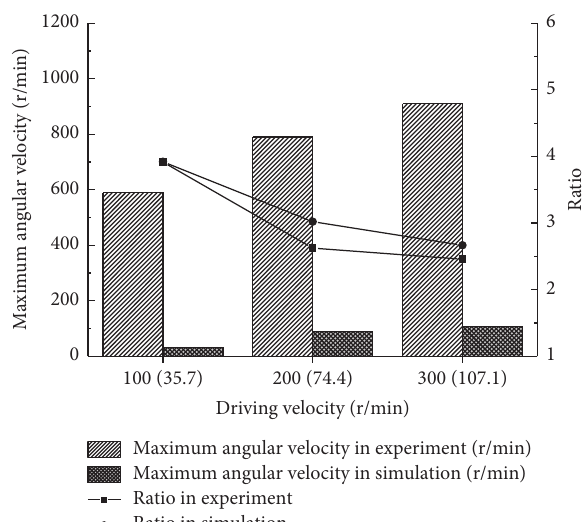
Figure 13: Driving and the maximum angular velocity of the numerical simulation.